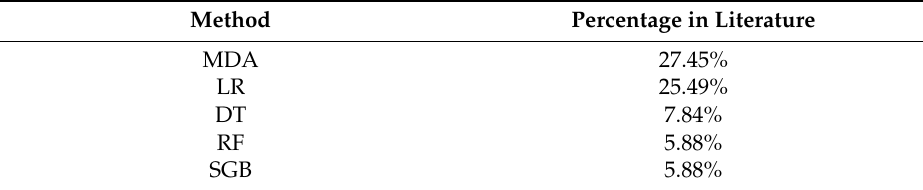
Table 1. Percentage comparison of different credit risk modelling (CRM) methods used in the